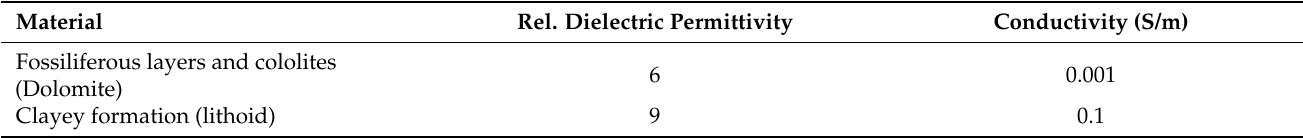
Table 3. Electromagnetic properties set up for media of model